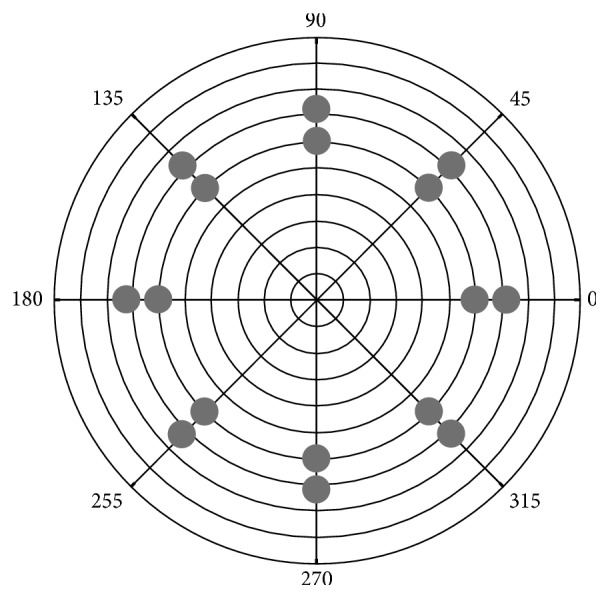
Pattern of the output laser beam. Inner and outer spot rings are applied at 3 and 3.6 mm from the center.